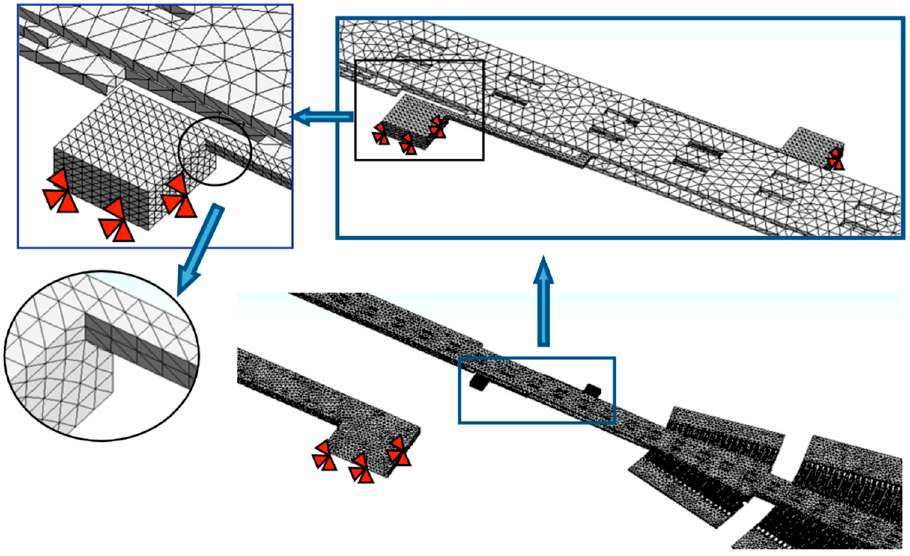
Figure 12. FEM model of the microgripper using solid187 elements of ANSYS software.